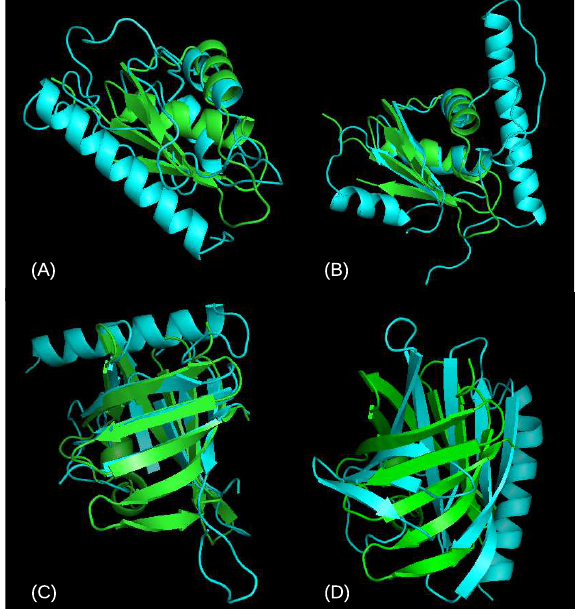
Figure 4. Structures for the top scored models for the two worst cases in Figure 3 using UNRES and OUNRES. Native structures are given in green, decoy model structures in cyan. ( A ) UNRES best for ( C ) UNRES best for target T0782, model SAM-T08-server-TS2; ( D ) OUNRES best for target T0782, model